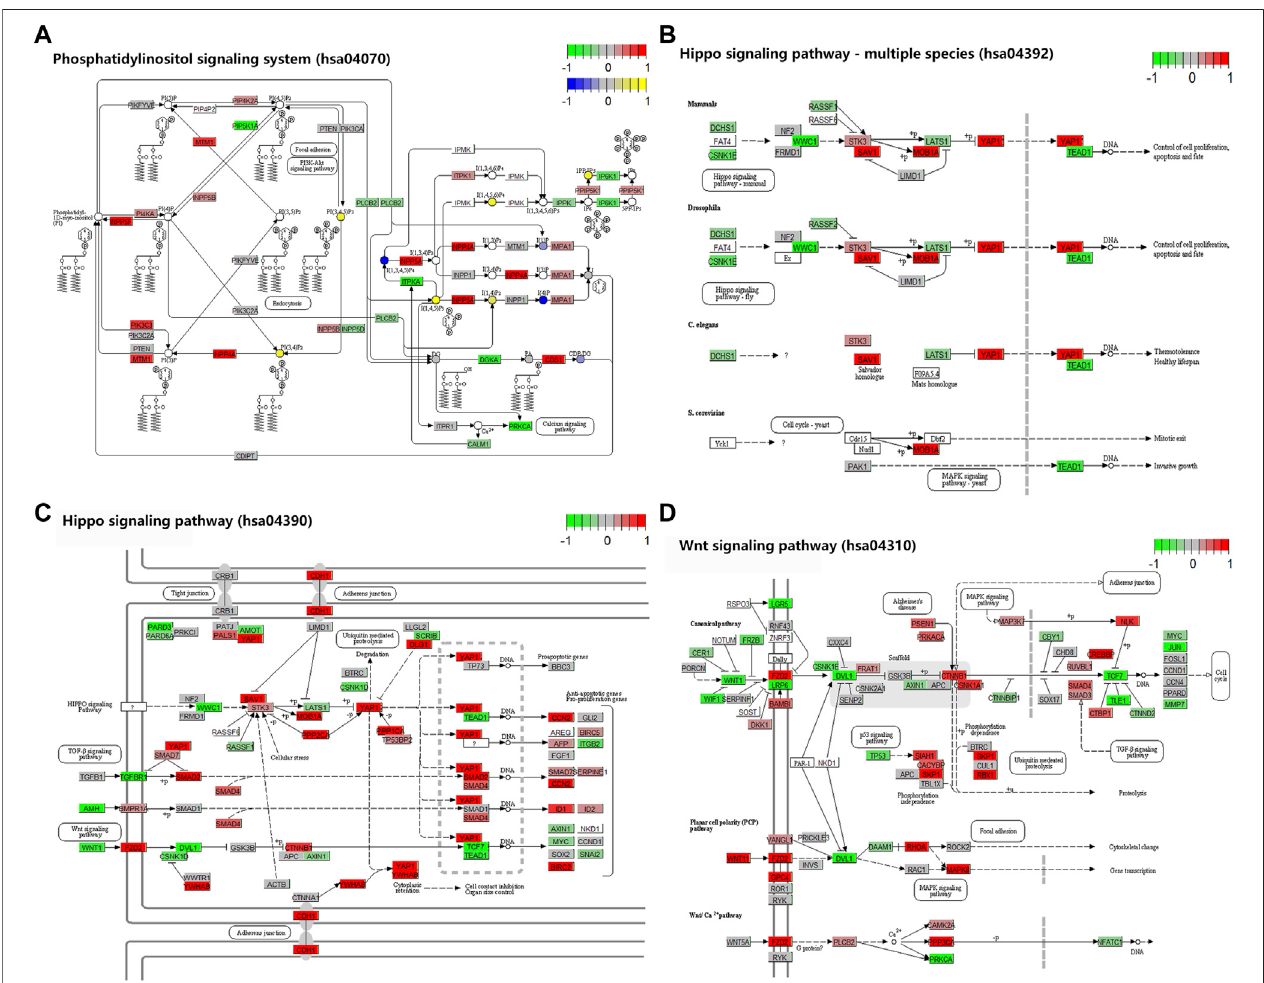
FIGURE 3 | Four major KEGG pathways. (A) Phosphatidylinositol signaling system. (B) Hippo signaling pathway – multiple species. (C) Hippo signaling pathway. (D) Wnt signaling pathway. The colors in the graph from red to green indicate the change from high to low in m 6 A dysregulation on genes. The colors in the graph from yellow to blue indicate the change from high to low in m 6 A dysregulation on